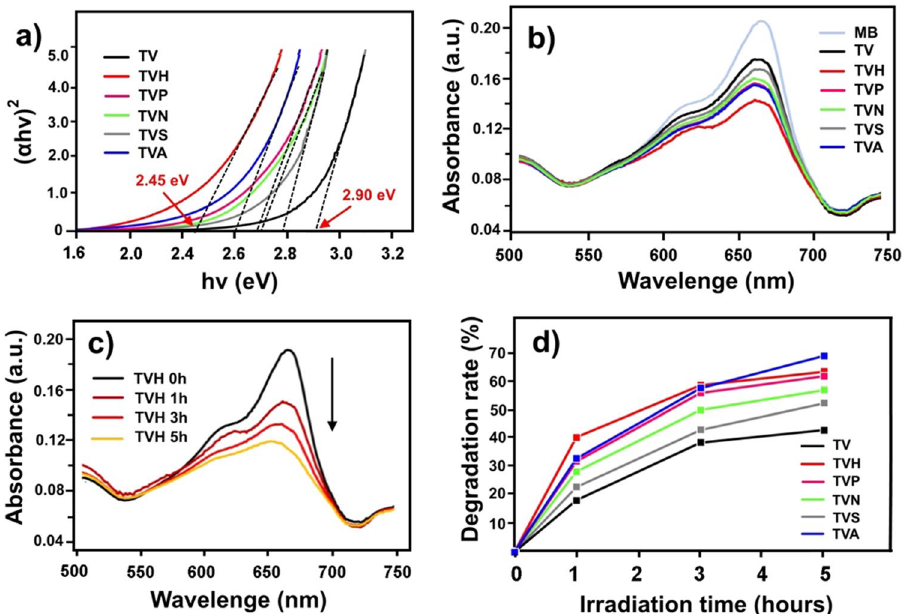
Figure 5. ( a ) Tauc plot, ( b ) absorption spectra for MB degradation in 1 h, ( c ) photocatalytic activity of TVH sample, and ( d ) percent photocatalytic degradation